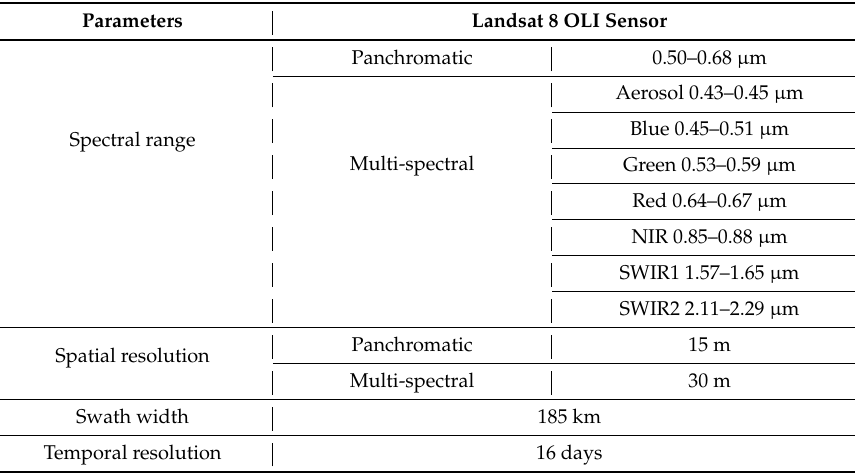
Table 3. Parameters of the Landsat 8 OLI